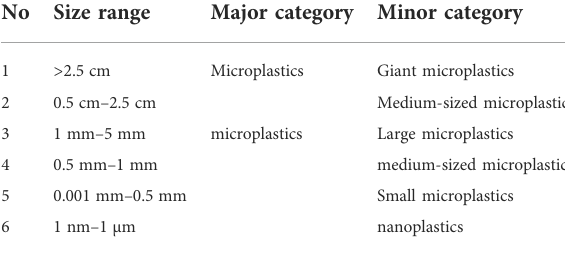
TABLE 2 Microplastic size classi fi cation